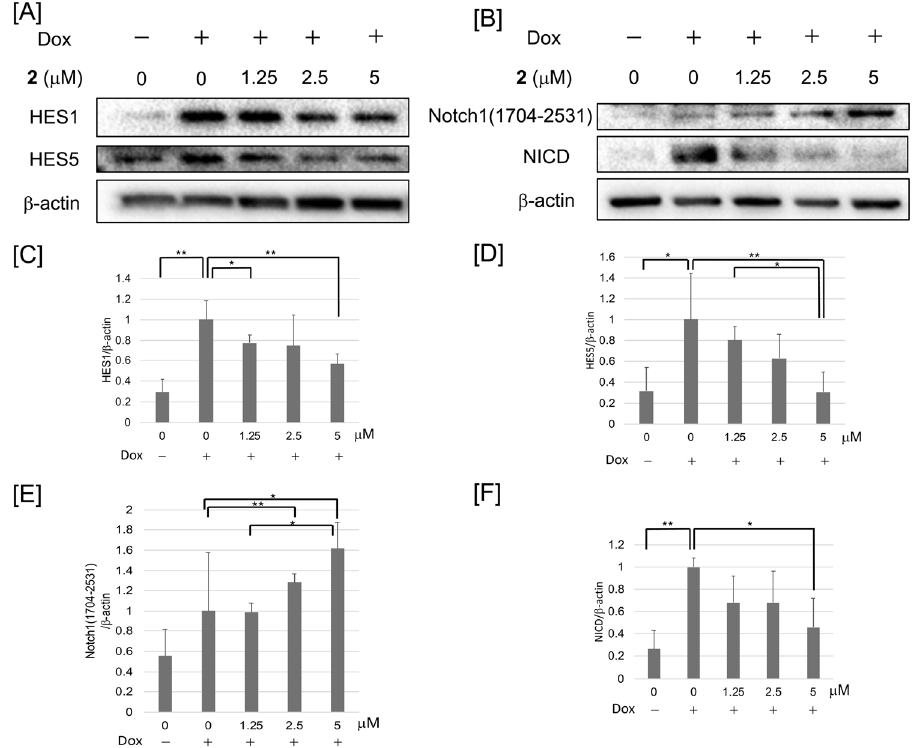
Figure 6. Inhibition of protein expression by cowanin ( 2 ) in assay cells. Assay cells (LS174T Notch cells: 1 × 10 6 cells/dish) were incubated in a 6-cm dish for 12 h at 37 °C. After another 12 h incubation with 50 ng/ mL Dox, and cells were washed with PBS. Medium was changed to fresh medium with 2 and incubated for 12 h. The effect on protein expression was analyzed by Western blotting. β -Actin was used as internal control. ( A ) Western blot analysis of HES1 and HES5 expression in assay cells after treatment with cowanin ( 2 ). ( B ) Western blot analysis of Notch1(1704–2531) and NICD expression in assay cells after treatment with cowanin ( 2 ). ( C – F ) Relative protein levels analyzed by densitometry. Data are presented as the mean with SD from three independent experiments. * P < 0.05 and ** P < 0.01 are considered statistically significant. P values were analyzed by Student’s t